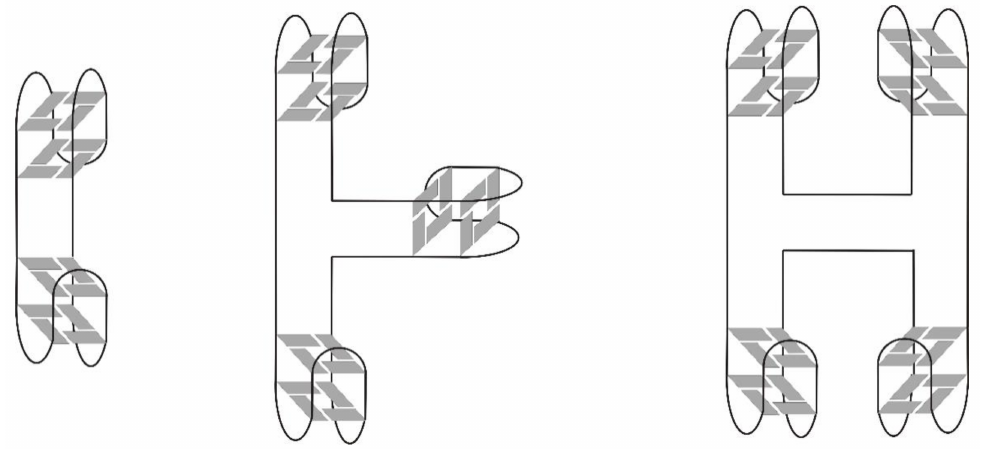
Figure 13. Schematic presentation of circular quadruplex–quadruplex junctions based on studies by Di Giusto and King